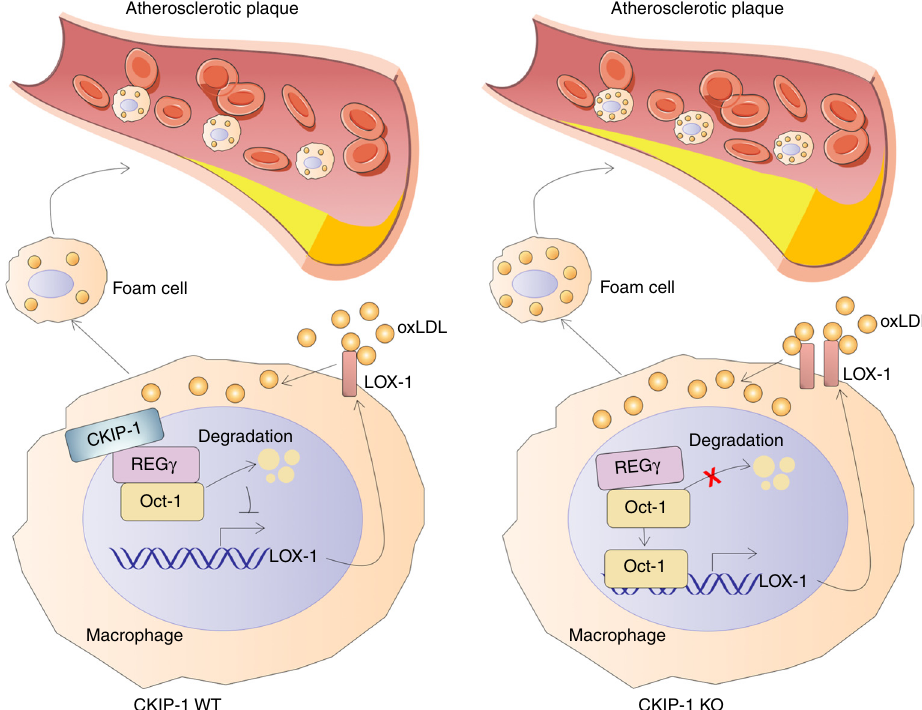
Fig. 8 A proposed model for the role of CKIP-1 in atherosclerosis. CKIP-1 regulates the formation of foam cells by coupling proteasome activator REG γ to target the transcription factor Oct-1 for degradation, thereby suppressing the transcription of LOX-1 and the macrophage lipid uptake. On the contrary, Ckip-1 de fi ciency results in the increased expression of LOX-1, facilitates uptake of oxLDL and accumulation of cholesterol within the cells, and